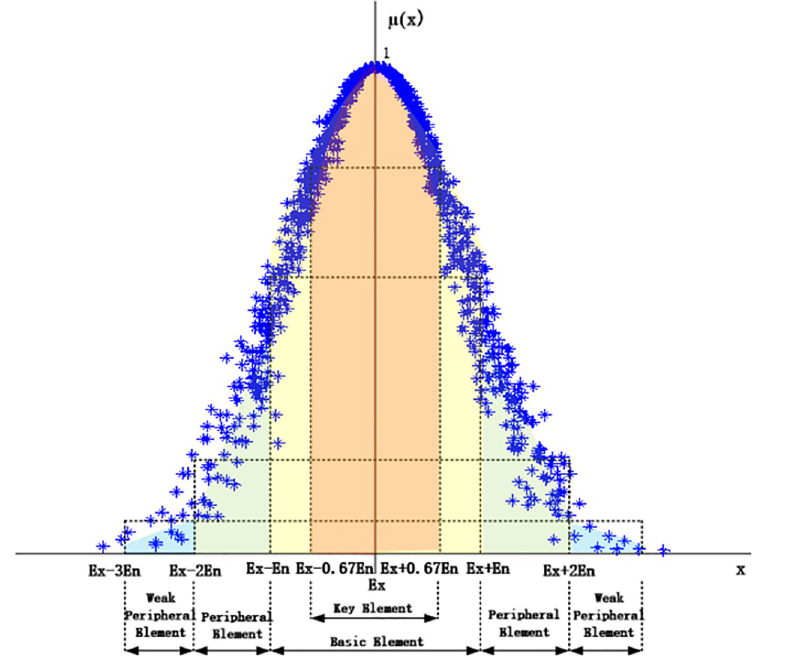
Fig 2. The importance division of normal cloud